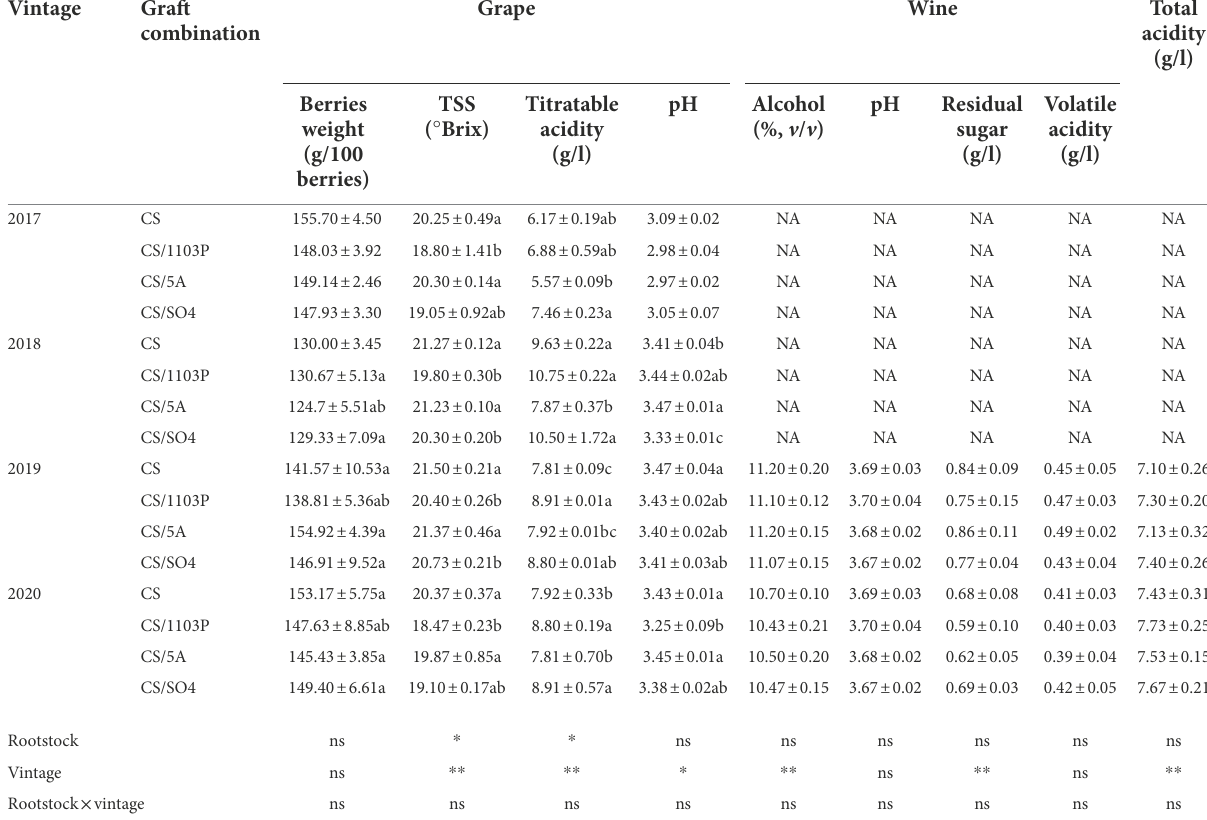
TABLE 2 Physicochemical parameters of graft combinations in berries and wines. Vintage Graft